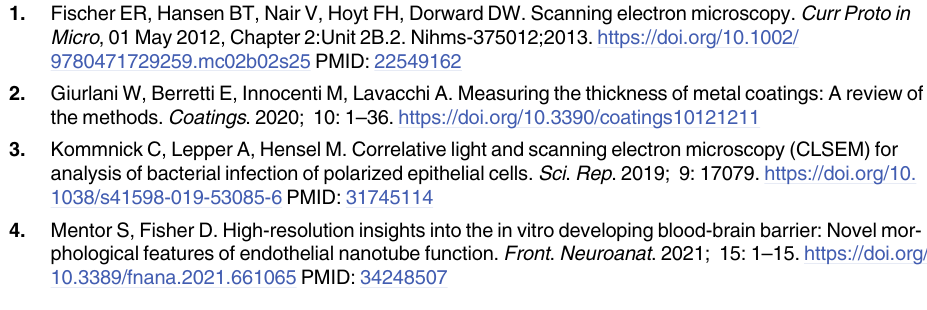
S1 Fig. A flow-diagram illustrating the preparation of brain endothelial cell monolayers for imaging using high-resolution electron microcopy. The flow-diagram illustrates the pro- cess of monolayer development on a mixed cellulose esters insert membrane, fixation of the BEC monolayer. Fixation was followed by dehydration within a series of graded ethanol con- centrations and, thereafter, it underwent critical point drying, replacing ethanol with liquid carbon dioxide at high pressure and regulated temperature until the critical point was reached. After drying, the biological samples were sputter-coated with carbon and Au:Pd in order to ensure the preservation of the sample in its native state when viewed under